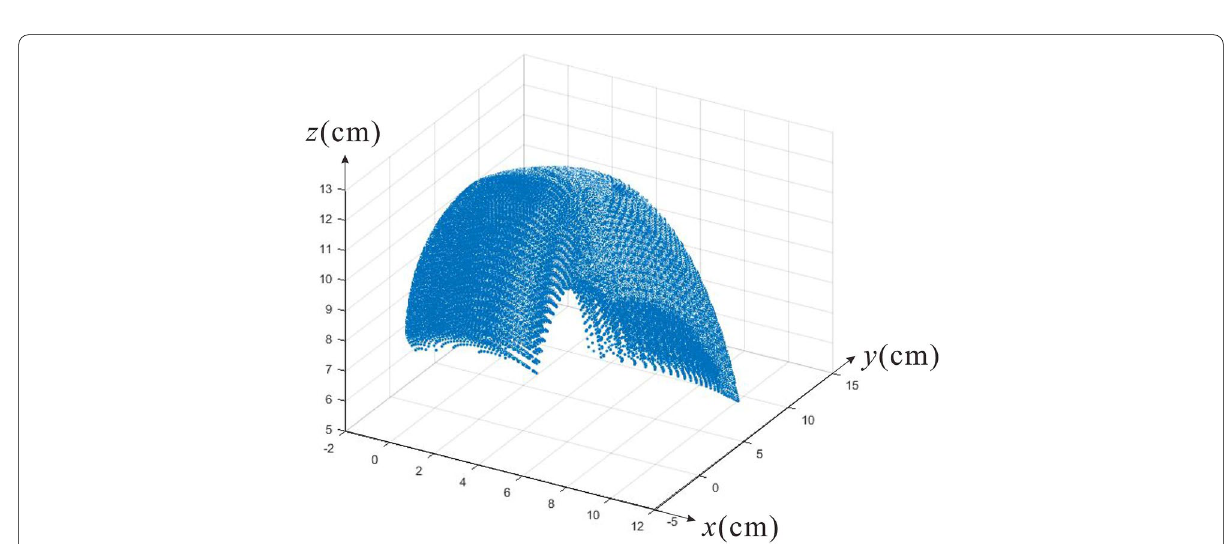
Figure 11 Workspace of the fingertip of finger